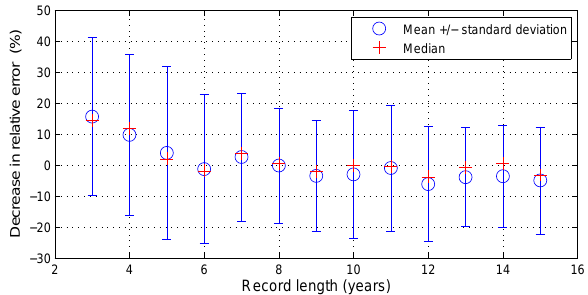
Figure 10. Mean ( ± SD) and median decrease in relative percentual error when using short records (3–15 years long) and the derived distribution instead of direct computation from the sample annual totals to estimate the long-term (32 years) standard deviation of an- nual rainfall at 52 locations in